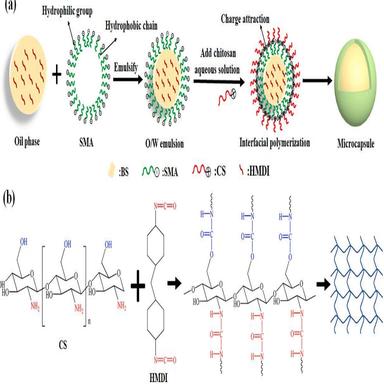
(a) Formation process of MicroPCMs prepared via interfacial polymerization, (b) chemical structure of CS, HMDI and reaction formula between -NH2/-OH and -NCO.